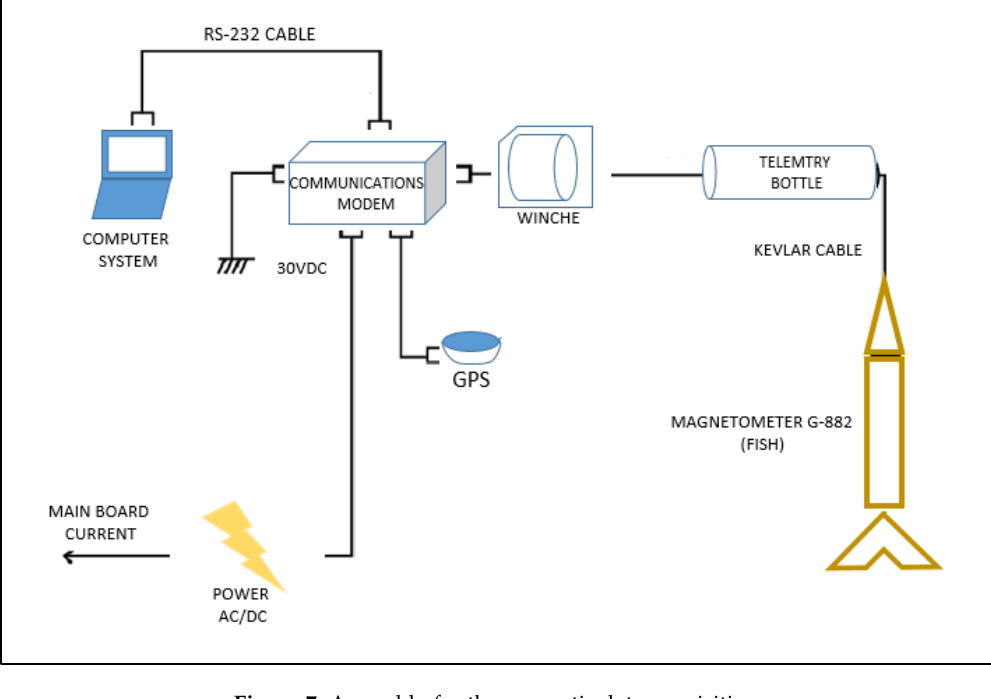
Figure 7. Assembly for the magnetic data acquisition.